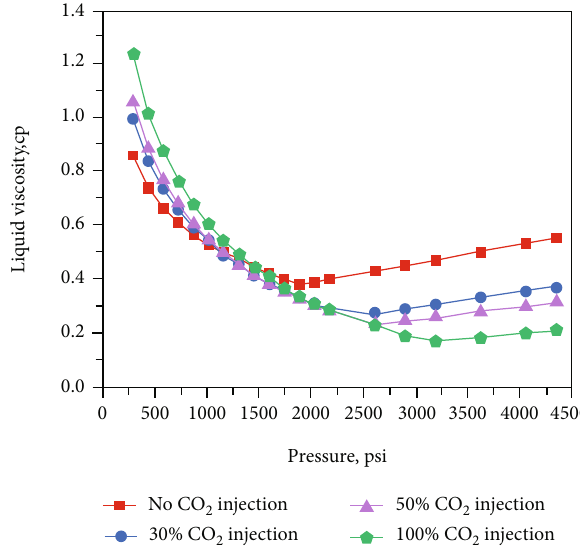
Figure 14: Oil viscosity of the Bakken tight oil versus pressure at injections at T = 230 ° F. various CO 2